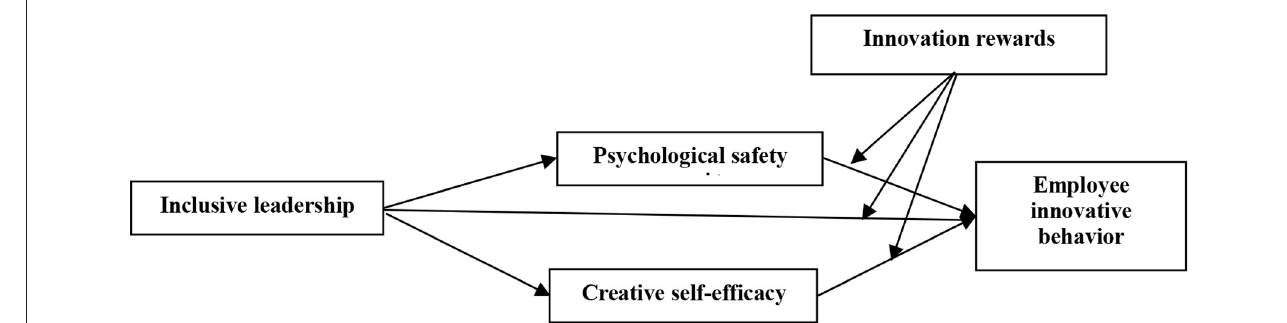
FIGURE 1 | Theoretical